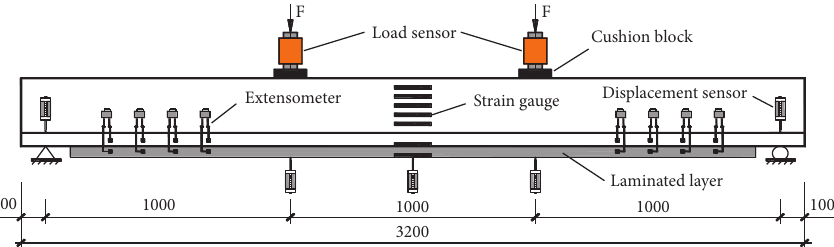
Figure 4: Details of single-span composite T-shaped beam test